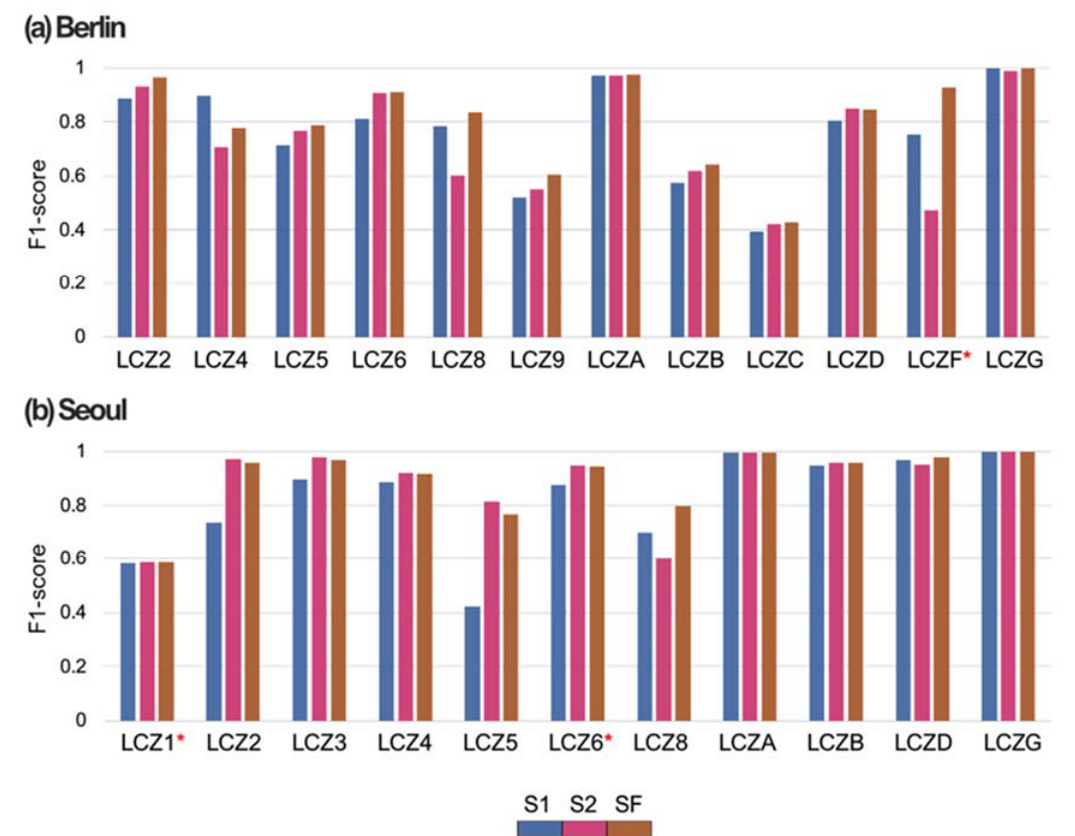
Figure 5. F1 ‐ scores of each LCZ class for the three schemes (S1, S2, and SF) in Berlin ( a ) and Seoul ( b ). The asterisk (*) indicates the red ‐ star classes.